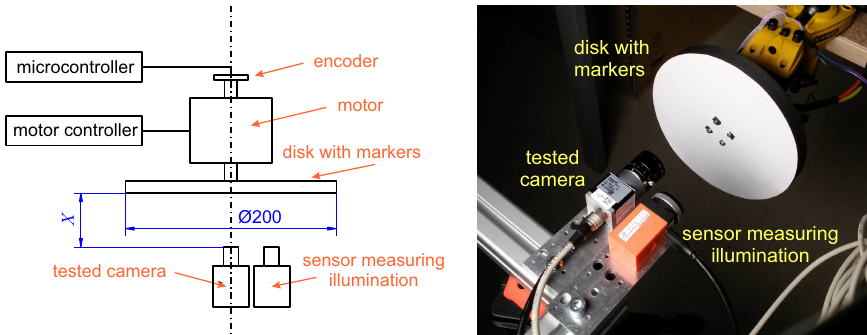
Figure 1. ( Left ) Schematic layout of the rotating disk experiment. The panel light is behind the cameras; ( Right ) a photograph of the rotating disk experiment.